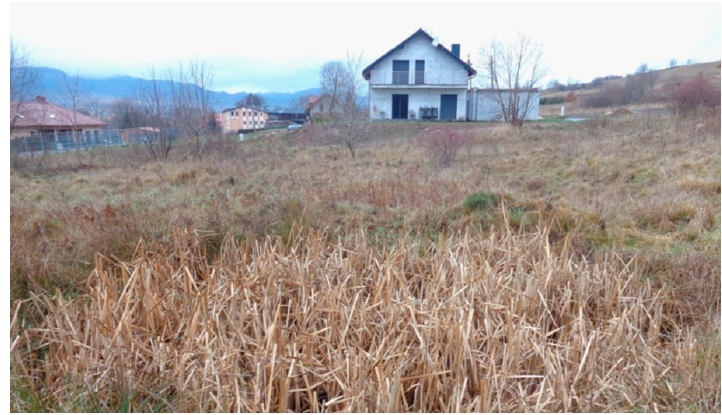
Figure 8. Contemporary house built on the site of the former AL Kaltwasser camp; photo P Lewandowski.